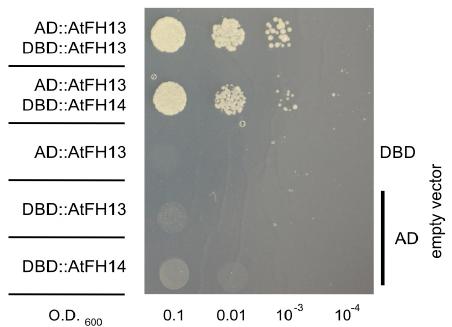
Figure 9. Yeast two-hybrid assays documenting heterodimerization of FH2 domains of AtFH13 and AtFH14. Serial dilution series of yeast transformants harboring the indicated constructs starting with OD 600 = 0.1 were plated on media without adenine (-Ade), histidine (-His), leucine (-Leu), and tryptophan (-Trp) as indicated. DBD: DNA binding domain; AD: activation domain.